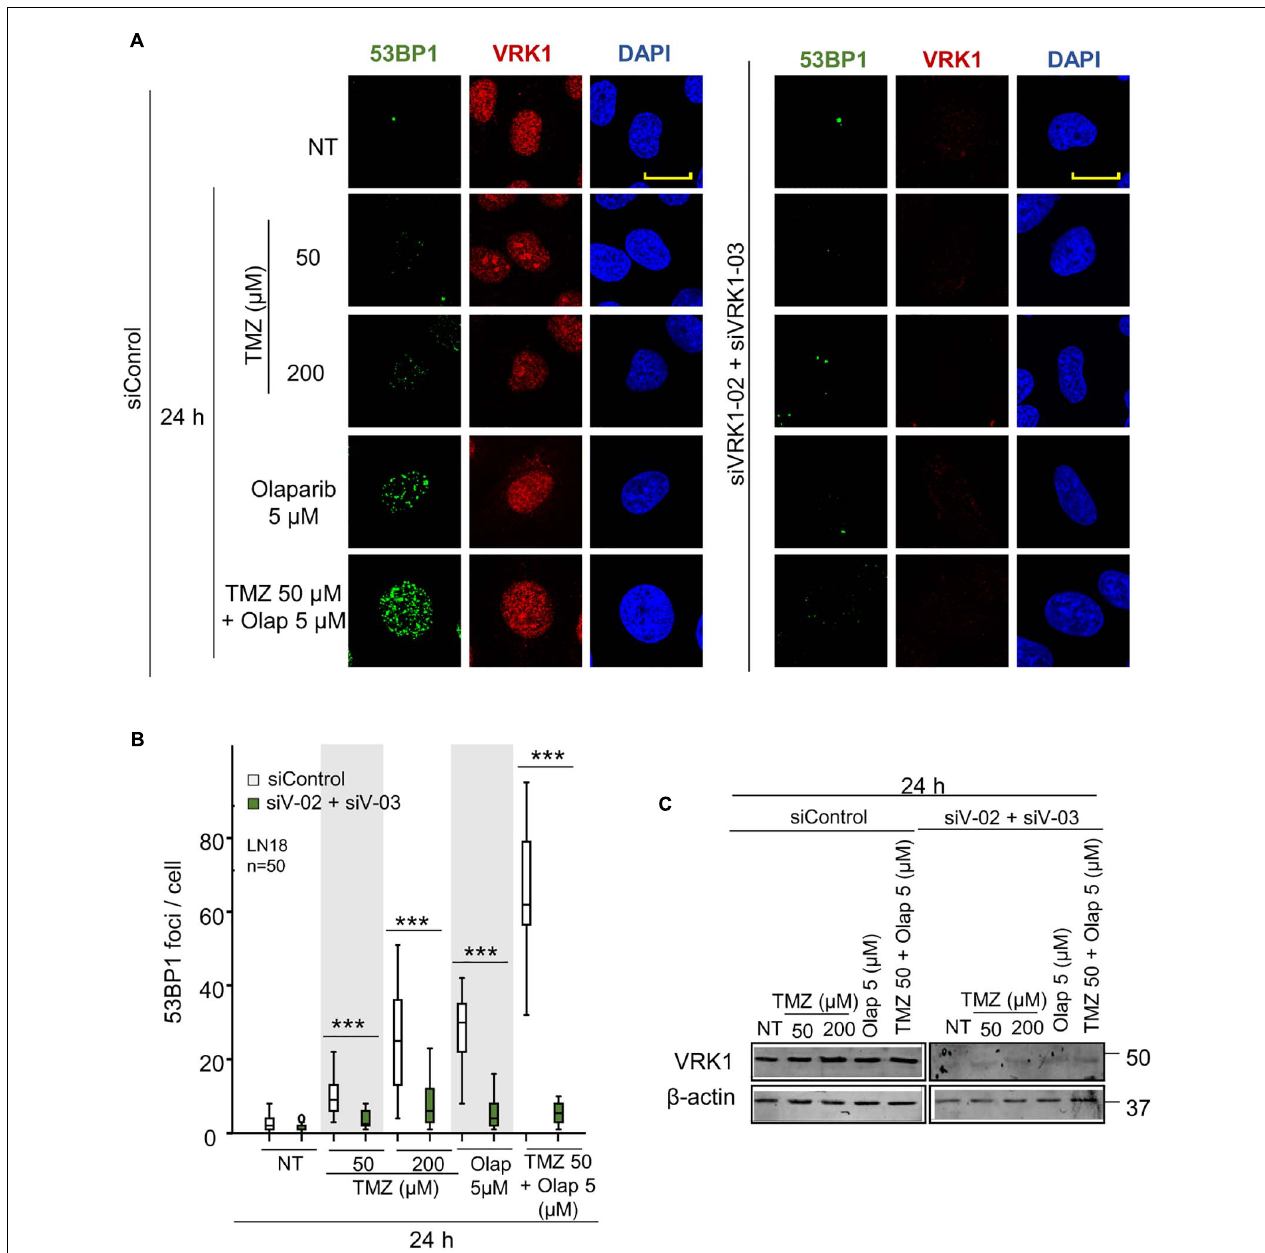
FIGURE 5 | VRK1 knockdown prevents 53BP1 foci formation after TMZ and olaparib treatments in LN-18. (A) Left. Effect of siControl on 53BP1 foci formation induced by TMZ, olaparib and their combination. Right. Effect of the combination of siVRK1-02 and siVRK1-03 on 53BP1 foci formation induced by TMZ, olaparib and their combination. (B) Quantification of the effect of VRK1 depletion on 53BP1 fluorescence per nuclear area. Fifty cells per condition in triplicate were quantified. Field images shown in Supplementary Figure 9 . NT: no treatment. Scale bar = 10 µ m. *** p < 0.001. (C) Western blot showing the effect of VRK1. β -actin was used as load